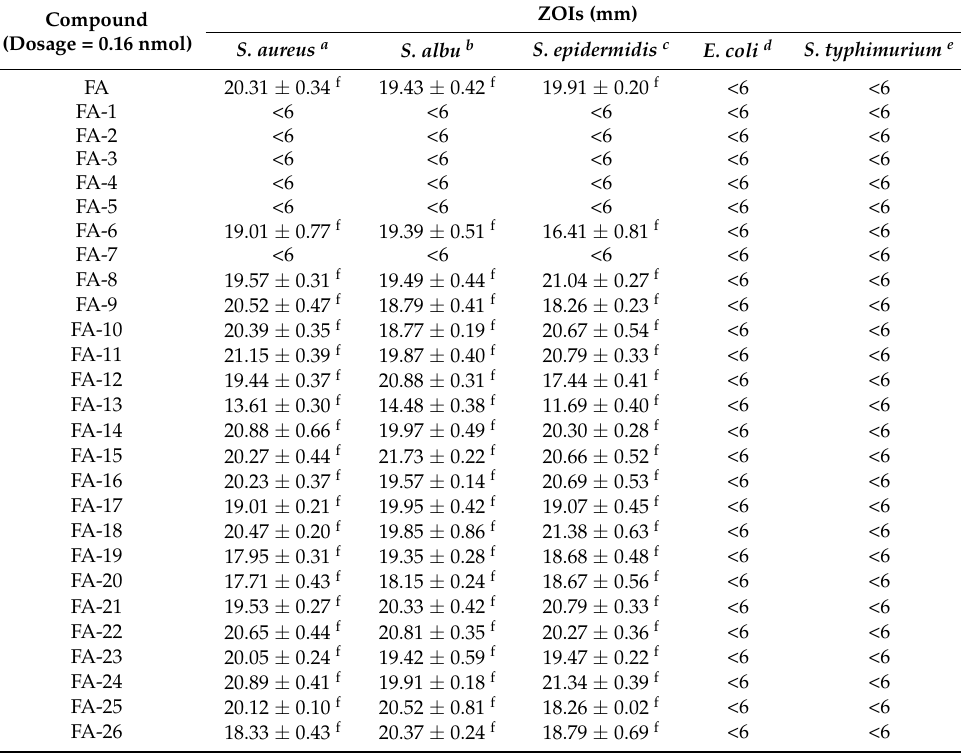
Table 1. Antibacterial activity of FA and its derivatives expressed in the inhibition.